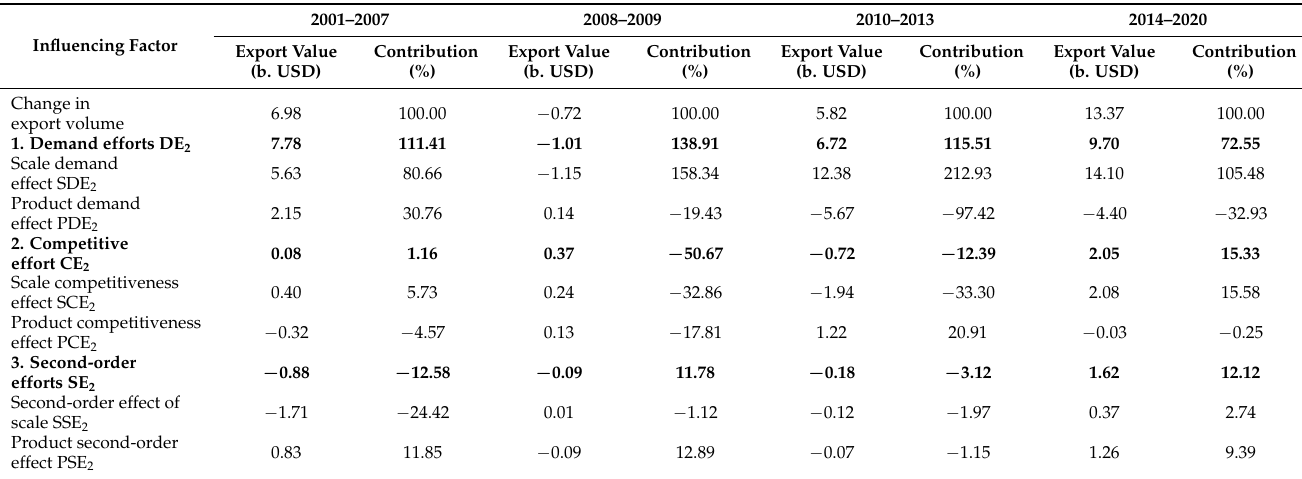
Table 2. B&R countries export agricultural to China fluctuations